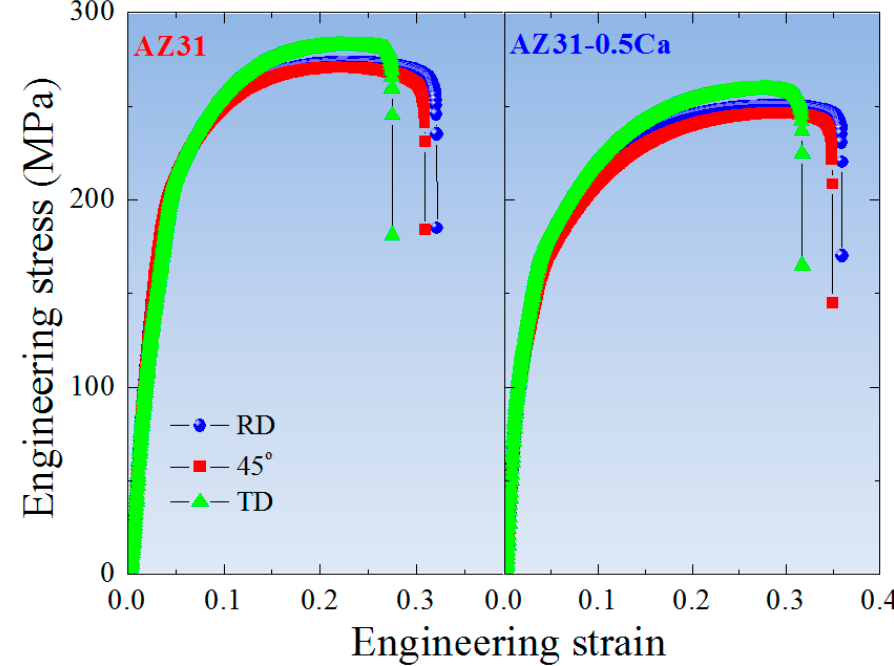
Figure 5. Room temperature engineering stress-engineering strain curves of the AZ31 and AZ31- 0.5Ca alloys along RD, 45° from RD, and